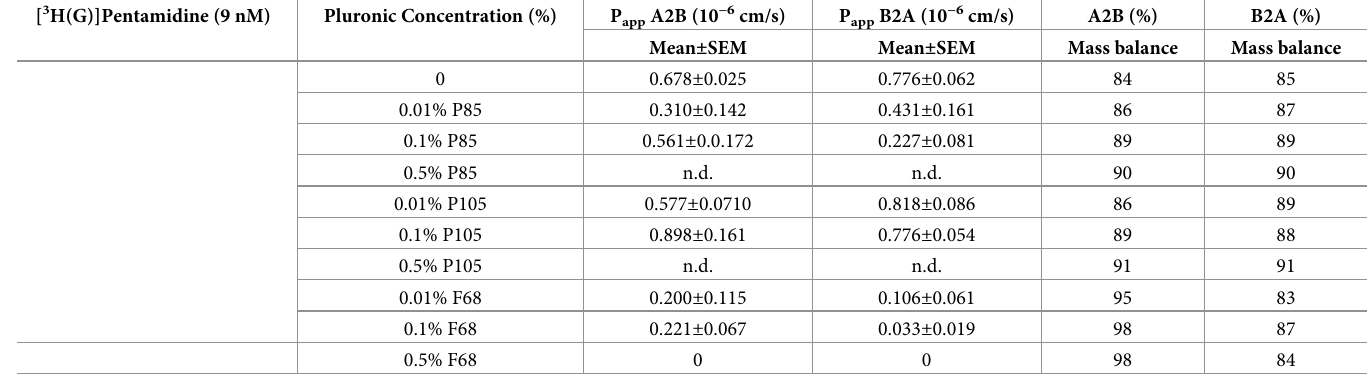
Table 9. The Effect of P85, F68 and P105 on the Apparent Permeability of [ 3 H(G)]pentamidine (9 nM) MDR1-MDCK Cell Monolayers in the Apical to Basolateral Direction and the Basolateral to Apical Direction. The percentage recovery of pentamidine is also shown. All the data has been corrected for extracellular space by sub- tracting [ 14 C(U)]sucrose (5.5 μ M) P app values which ranged from 0.89 to 2.00 x 10 − 6 cm/s. Each value represents three replicates for each n and n = 3. n.d. = not determined as integrity of the barrier compromised. [ 3 H(G)]Pentamidine (9